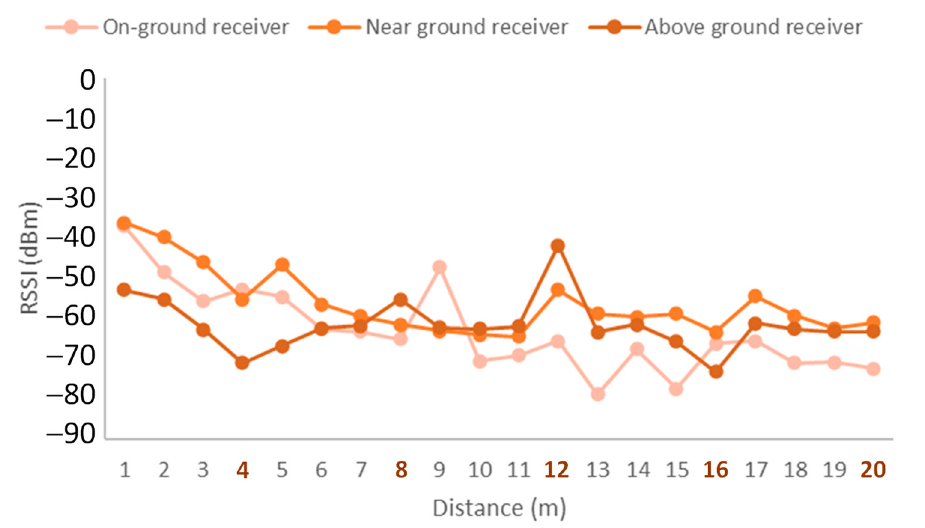
Figure 13. Testbed.